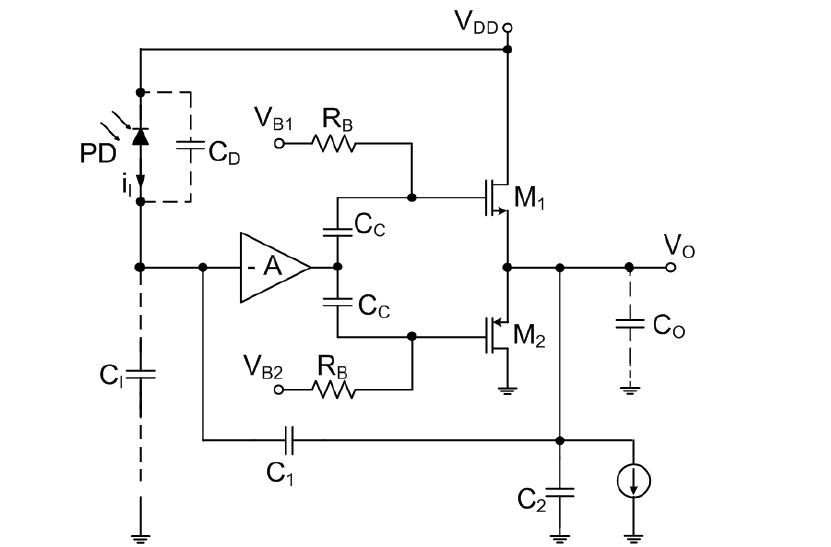
Figure 8. Capacitive-feedback TIA with push-pull buffer